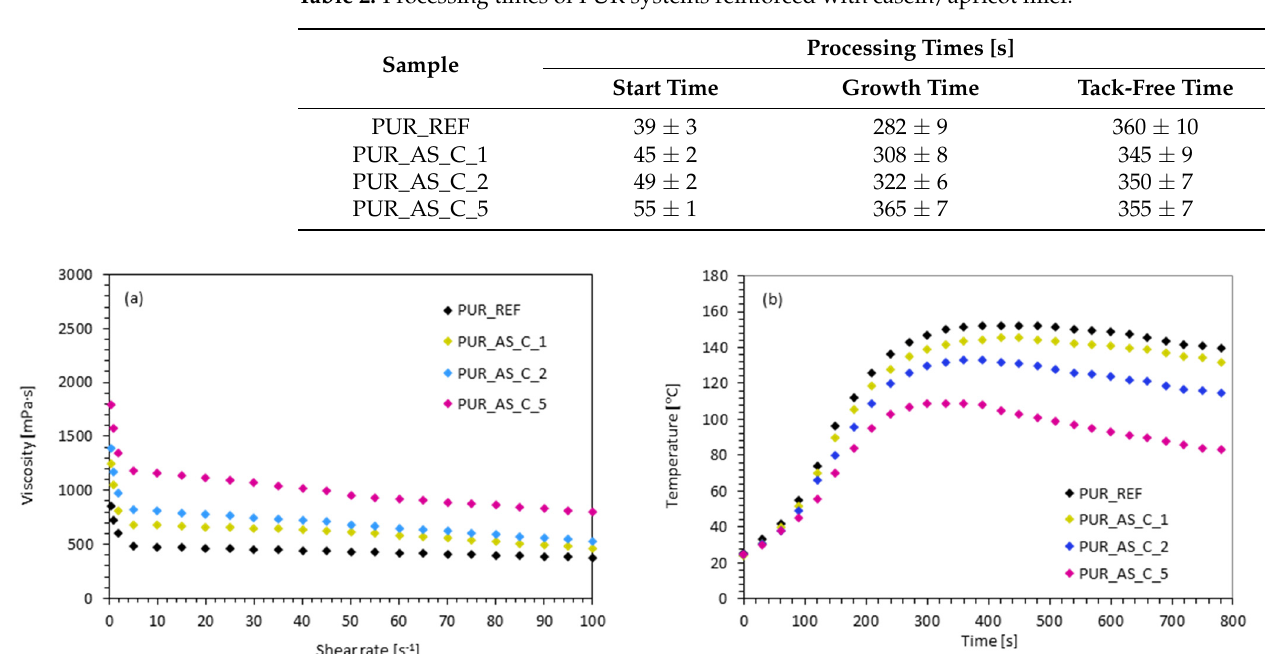
Table 2. Processing times of PUR systems reinforced with casein/apricot filler.